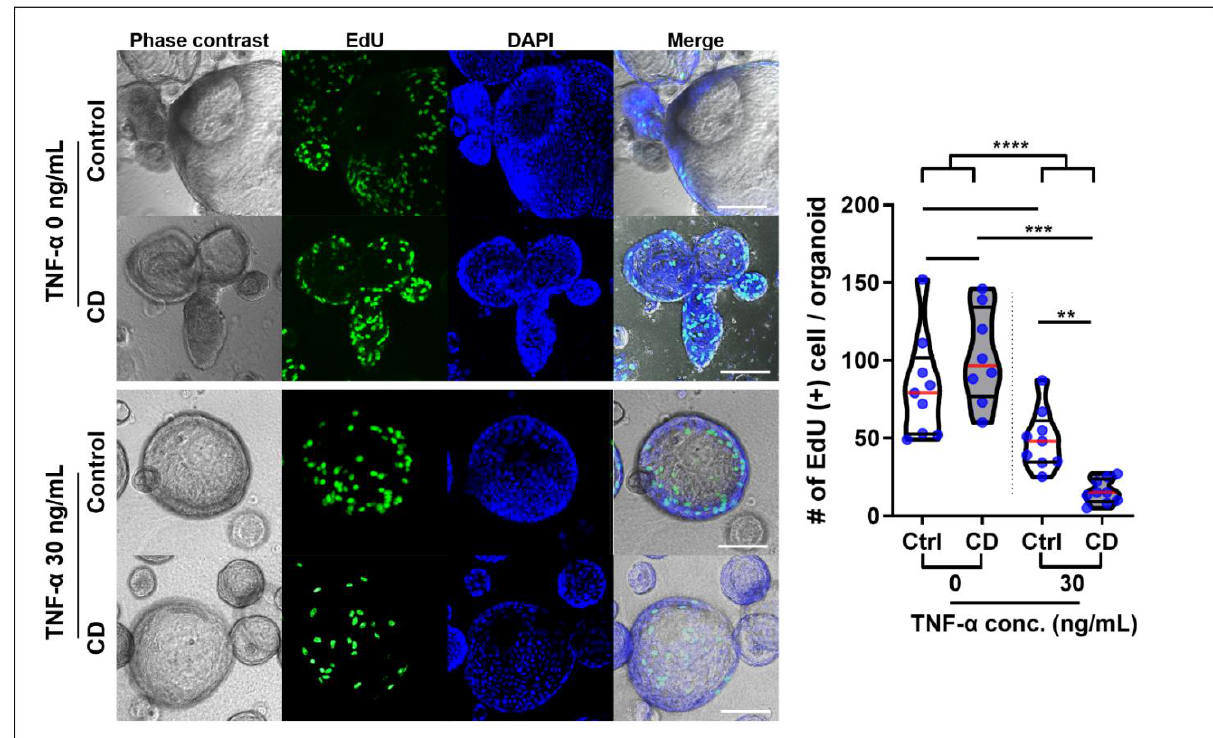
Figure 7. EdU assay for organoid proliferation in a TNFα-enriched condition EdU+ cell number was measured 2 h after EdU administration to 10 organoids from TNFα-treated and -free control and CD patient-derived organoids (n = 3 each). Differences were evaluated using ANOVA and Bonferroni’s multiple comparison test; ** p < 0.01, *** p < 0.001 and **** p < 0.0001.